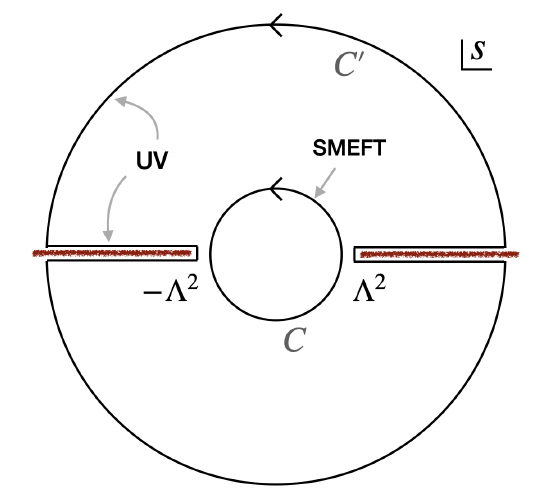
Figure 1 . Contour integrals in the complex s plane for the dispersion relation for d 2 M ijkl ( s ) / (2 ds 2 ) . The small contour denoted by “SMEFT” can be evaluated at low energies within the SMEFT, while the big contour denoted by “UV”, which can be deformed from the small contour, can only be fully evaluated in the UV completion. Even though the UV theory is unknown, the fundamental S-matrix properties of the UV theory provide useful information about this big contour C 0 , which, via the dispersion relation, can be used to constrain the small contour C that contains information of the Wilson